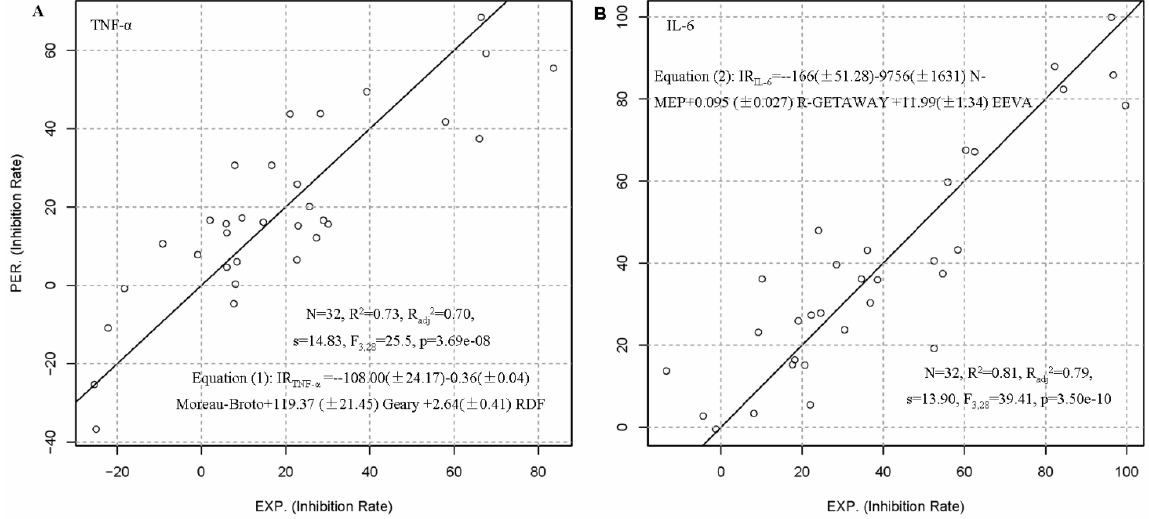
Figure 2. Plot of predicted activity against the corresponding experimental activity on TNF- α ( A ) and IL-6 ( B ) inhibition. N, the number of compounds taken into account in the regression; R 2 , the multiple correlation coefficient; R 2 , adjusted multiple correlation adj coefficient; s, residual standard error; and the F value is related to the F-statistic analysis (Fischer test). The numbers in parentheses mean the standard deviation of the